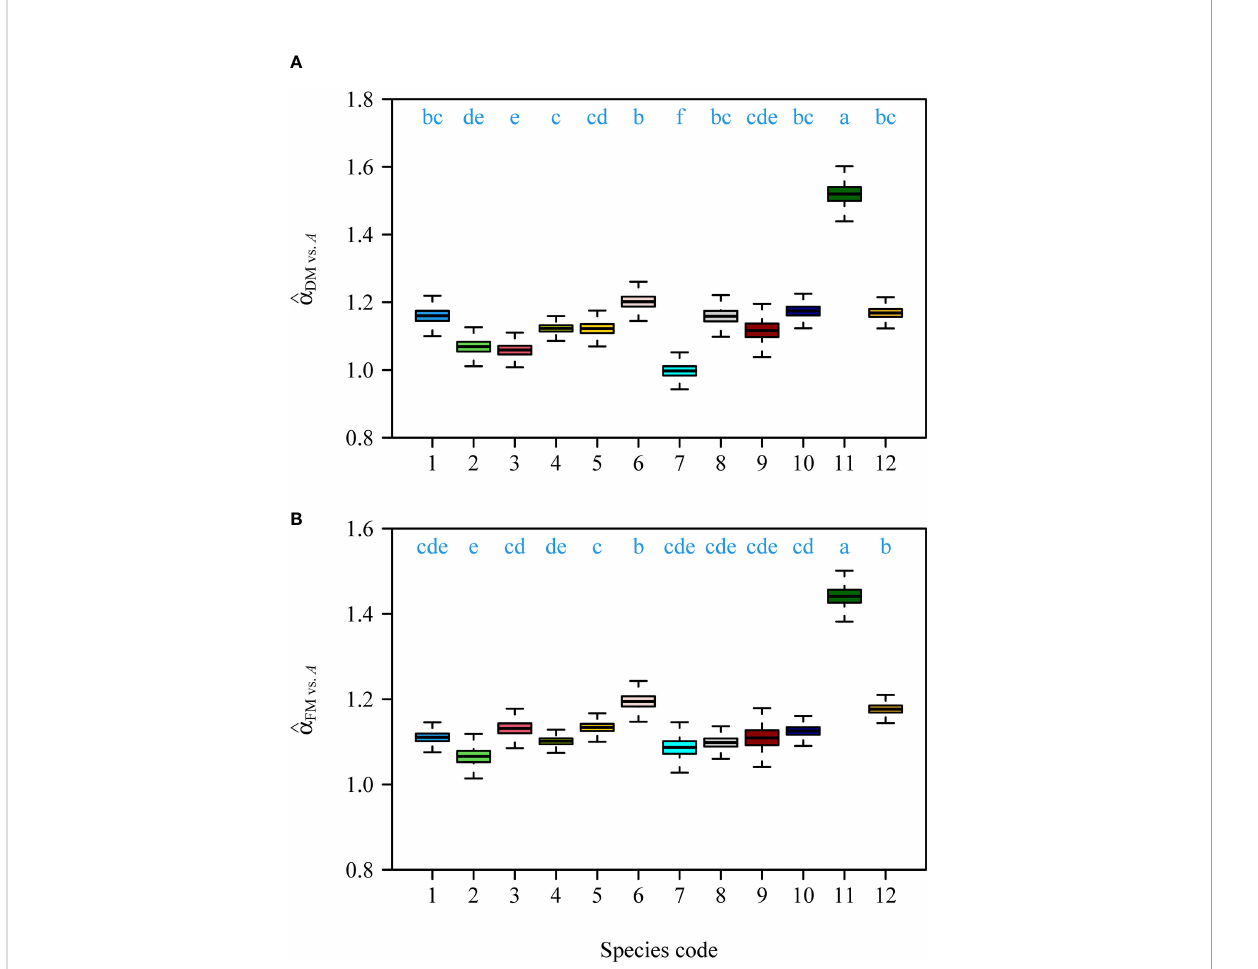
FIGURE 2 Comparisons of the estimated numerical values of the scaling exponents of DM vs. A among the 12 species (A) , and the estimated numerical values of the scaling exponents of FM vs. A among the 12 species (B) . The letters on the top of the whiskers signify the signi fi cance of the difference in the scaling exponent between any two pairs of the 12 species; the solid segments in the boxes represent the medians of the scaling exponents based on 3000 bootstrapping replications. Species codes associated with their binomials are the same as those in Table